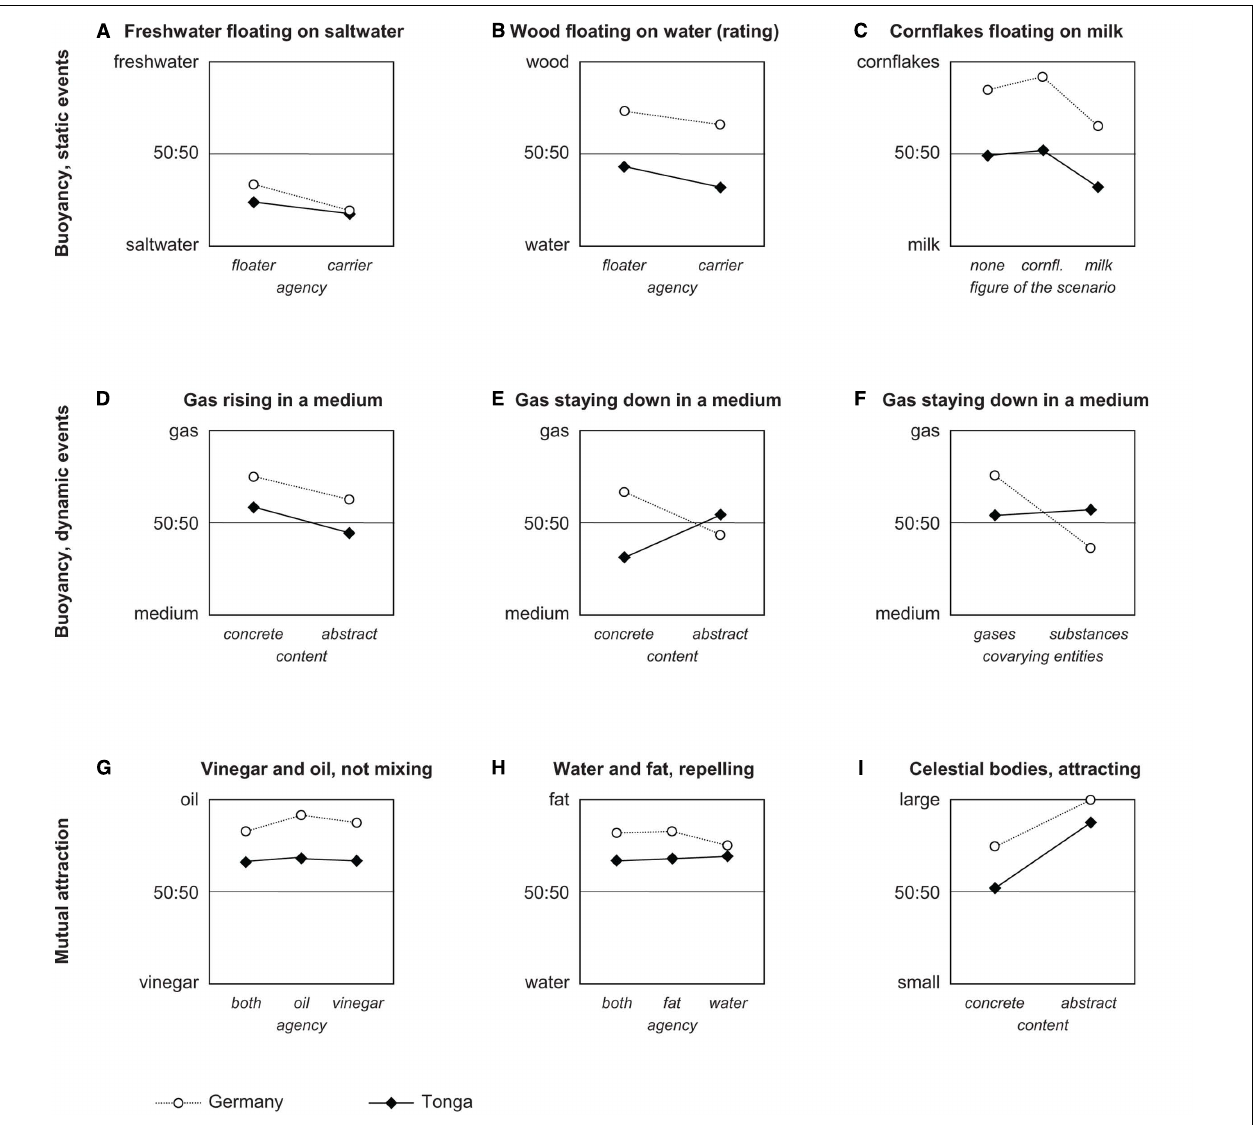
FIGURE 2 |Assignment of causality in the nine physical settings in Germany (white circles) andTonga (black